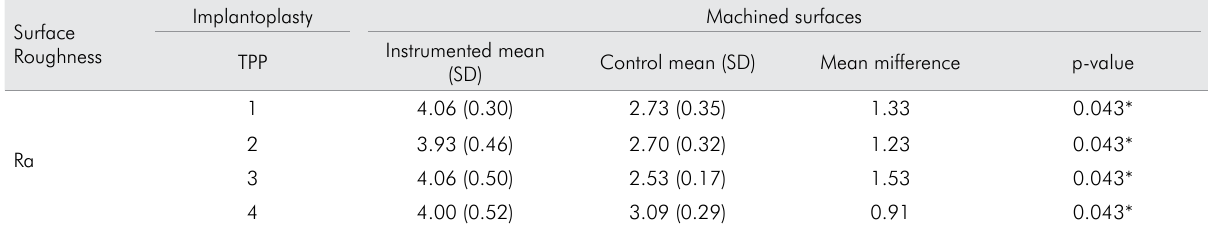
Table 2. Surface roughness averages and P-values for both instrumented and control surfaces of Machined Disks. Surface Roughness